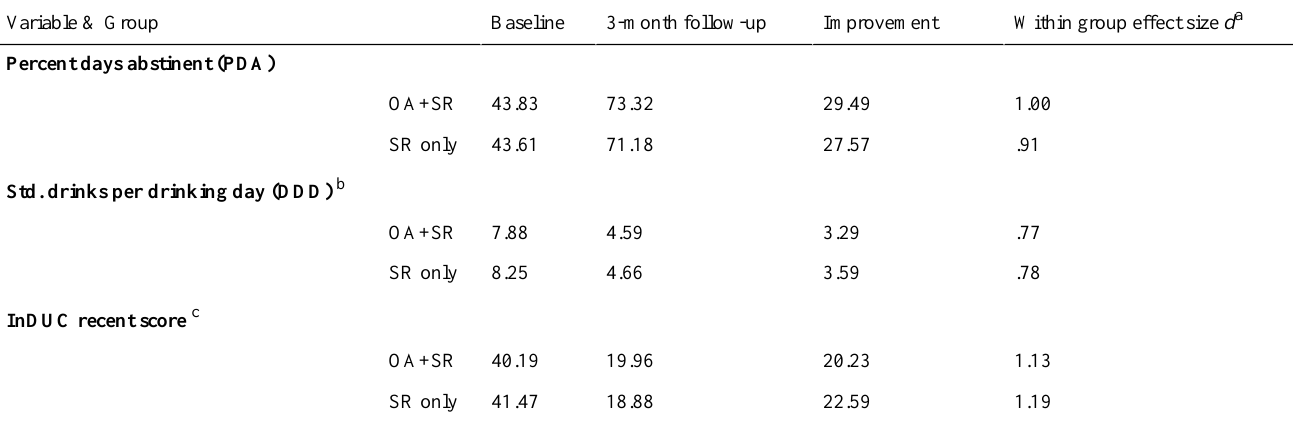
Table 2. Means and within group effect sizes for each outcome